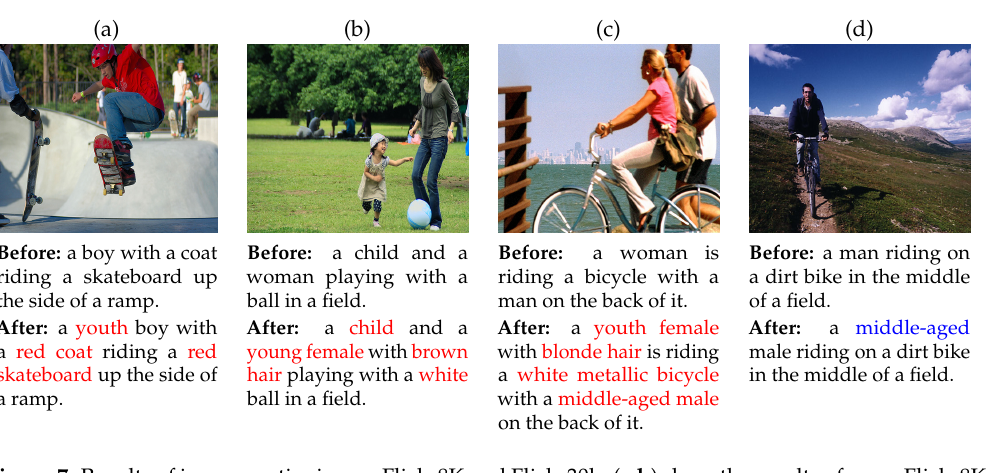
Figure 7. Results of image captioning on Flickr8K and Flickr30k. ( a , b ) show the results of some Flickr8K images, ( c , d ) show the results of some Flickr30K images. Red color indicates the positive example, and blue color indicates the negative